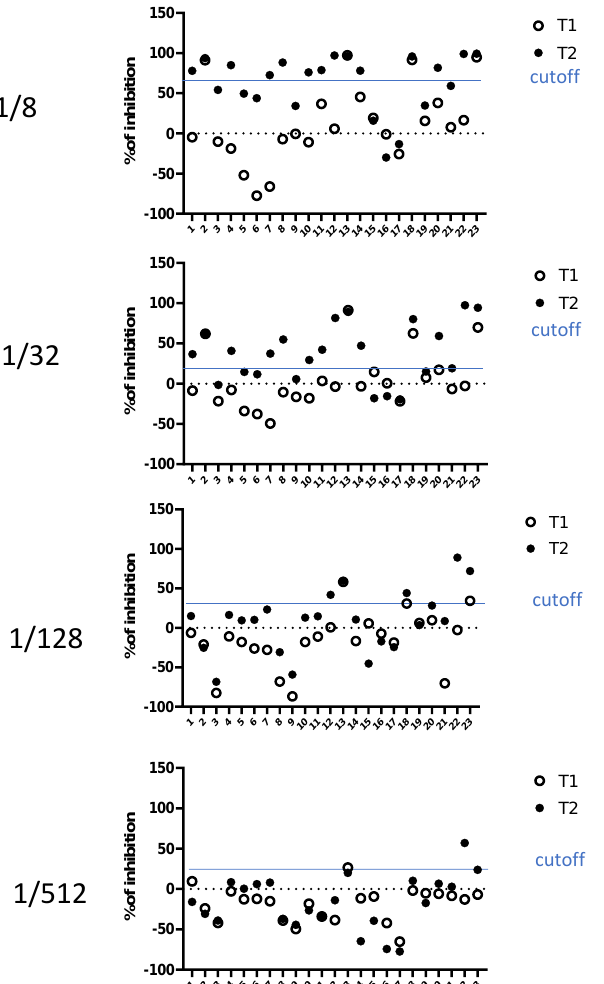
Figure 4. Impact of sera from COVID-19 patients on fusion at the moment of first symptoms and 2 weeks later. Coculture of Hela-S and Hela-ACE2 in the presence of various dilutions of sera (1/8 to 1/512) from COVID-19 patients at the moment of first symptoms (T1) or two weeks after (T2). Each luminescent signal is normalized with the value in the presence of an internal control, made of a pool of seronegative sera. Results are expressed as the percentage of inhibition compared to the internal control serum.